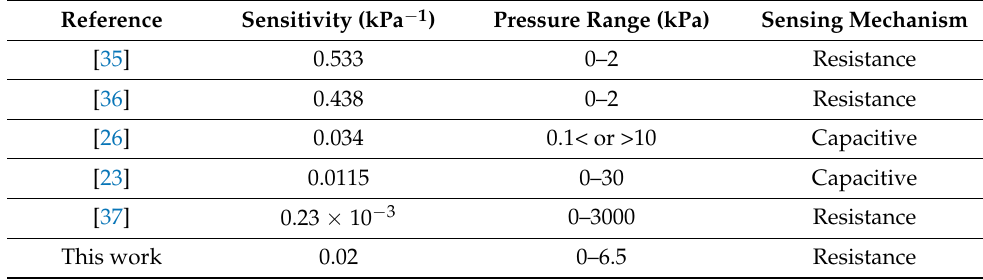
Table 1. Comparison of the sensitivity based on this work and previous